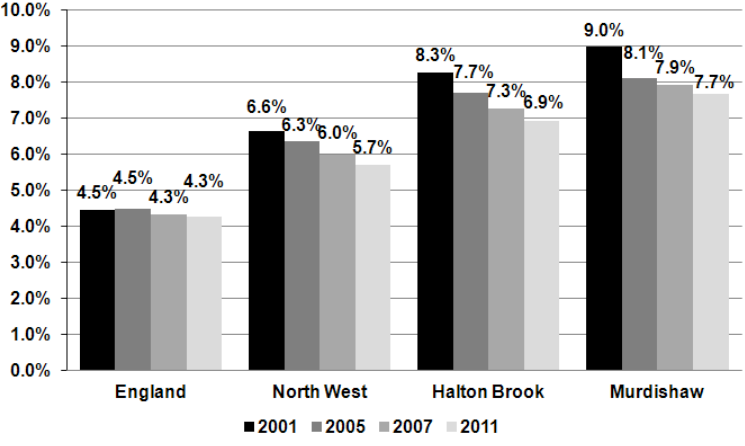
Figure 6. Percentage of people claiming incapacity